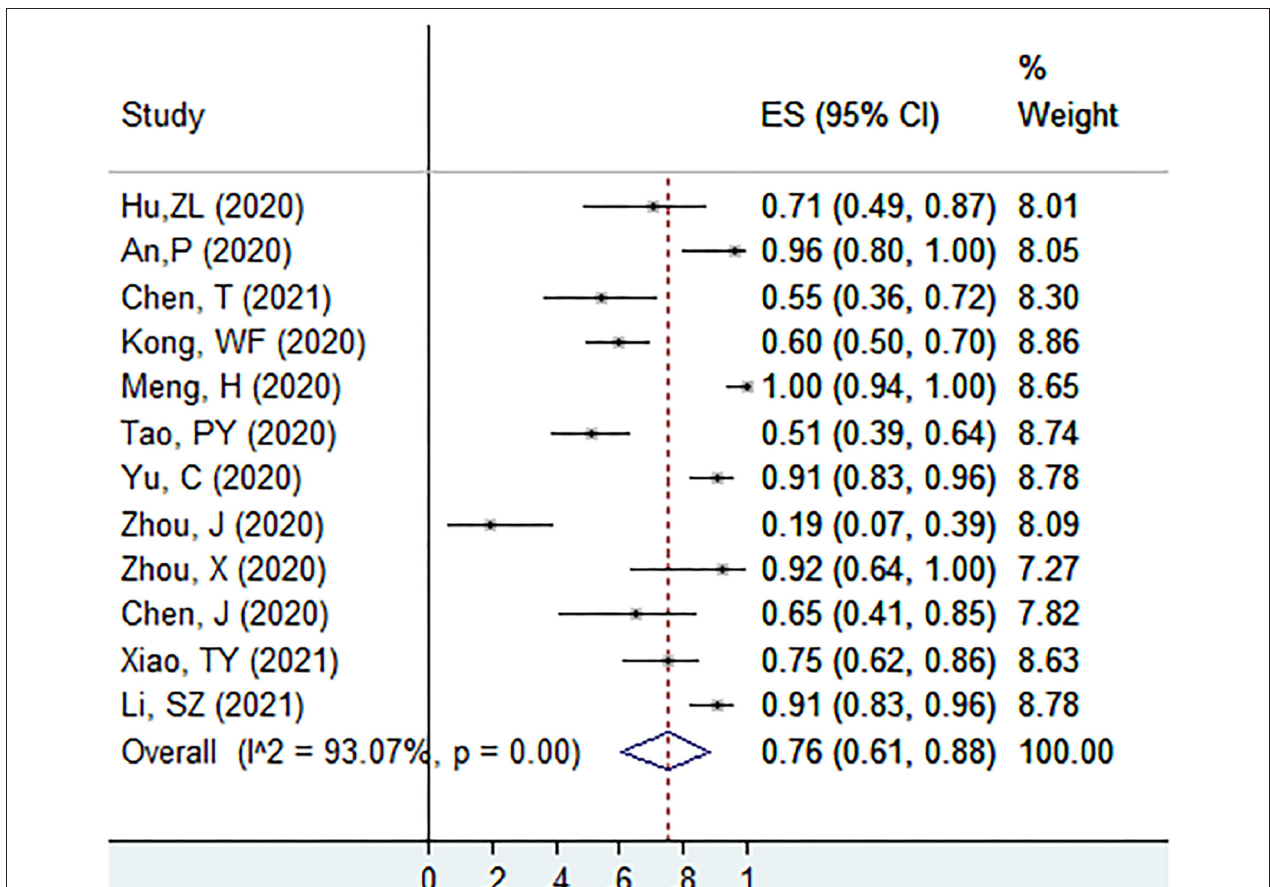
FIGURE 2 | The proportion of individuals with abnormal CT features in initial no-symptoms COVID-19 patients at the screening